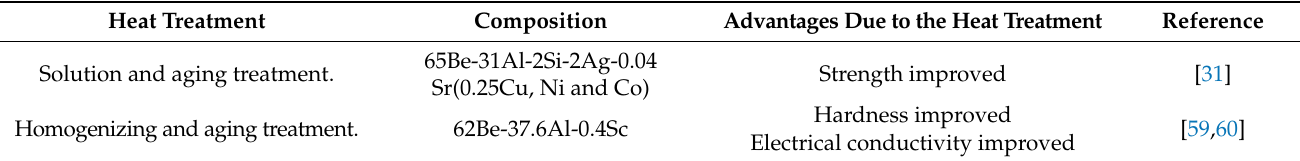
Table 4. The heat treatment of casting Be-Al alloy. Heat Treatment